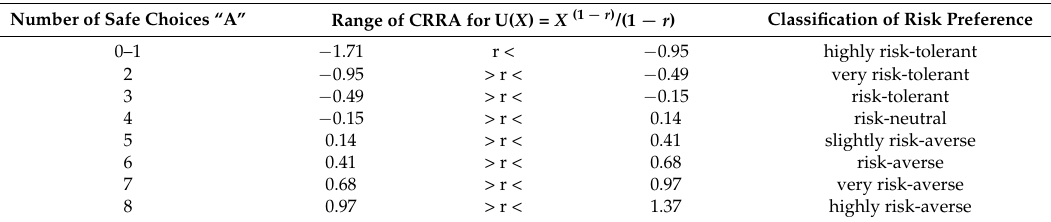
Table 5. Level of risk coefficients